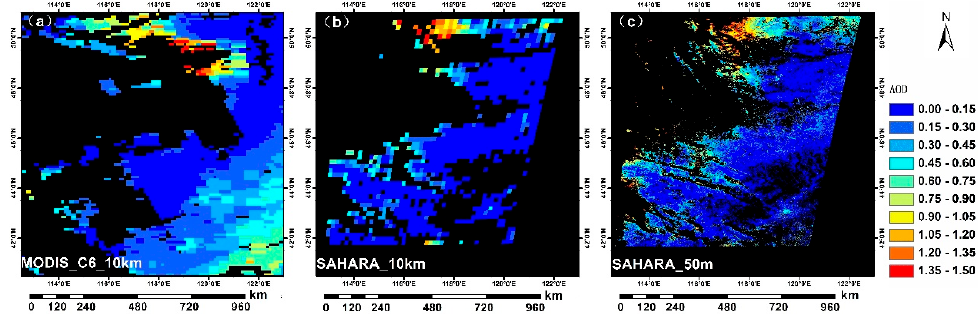
Figure 11. The comparison between SAHARA AOD from GF4 data and MODIS C6 combined AOD on 18 May 2016: ( a ) MODIS C6 combined AOD; ( b ) SAHARA 10 km AOD; ( c ) SAHARA 50 m AOD.